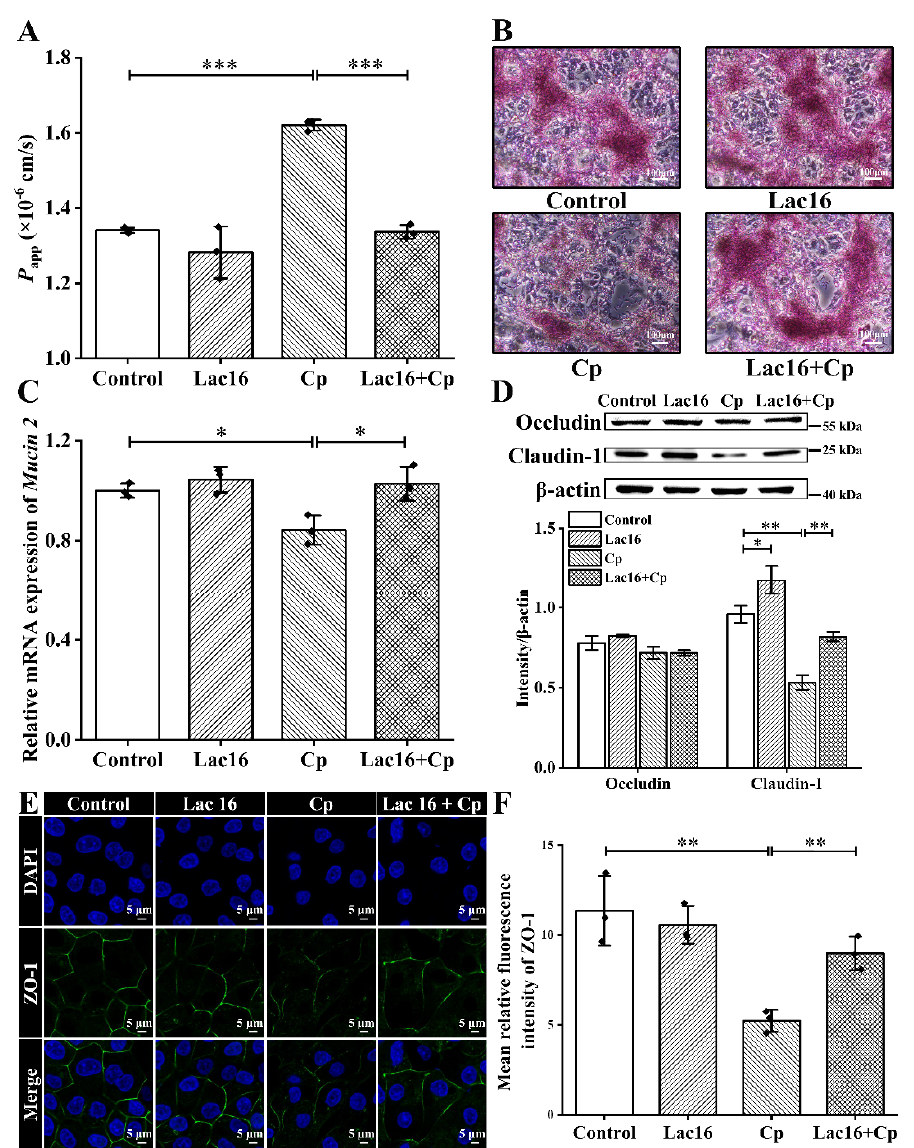
Figure 4. Intestinal barrier functions and tight junction proteins of IPEC-J2 cell monolayers. ( A ) P app of IPEC-J2 monolayers based on apical-to-basolateral flux of fluorescein sodium. ( B ) Mucin production was detected by PAS staining (Mucin, carmine). ( C ) Relative gene expression level of Mucin 2 . mRNA expression was standardized to β -actin expression. ( D ) Western blot detection of occludin and claudin-1 in IPEC-J2 cells, and the quantitative analysis of the expression levels of bands. β -actin was used as an indicator of protein loading. ( E ) Immunofluorescence staining of zona occludens-1 (ZO-1, green) in IPEC-J2 cells. Nuclei were counterstained using 4′,6-Diamidino-2-phenylindole dihydrochloride (DAPI, blue). All images were obtained at 63 × magnification in oil. ( F ) The mean relative fluorescence intensity of ZO-1 in panel E. Data are presented as the means ± SD for n = 3; * p < 0.05, ** p < 0.01, *** p < 0.001 ( t test).